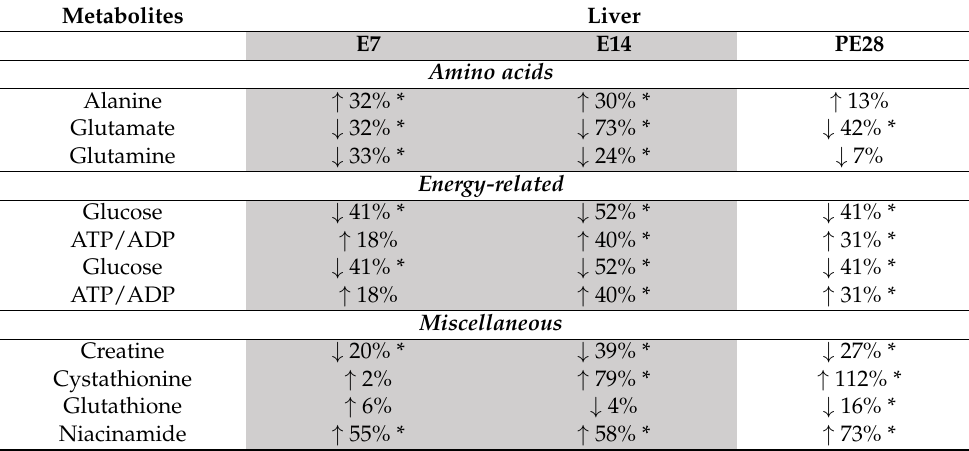
Table 2. Percent changes in concentrations of metabolites in the liver of white seabream ( D. sargus ) following MeHg-dietary exposure (E7, E14) and post-exposure (PE28) periods in relation to control groups (n = 6) (Dunnett’s test, * p < 0.05; ↑ and ↓ indicate an increase and decrease in respect to the control group,